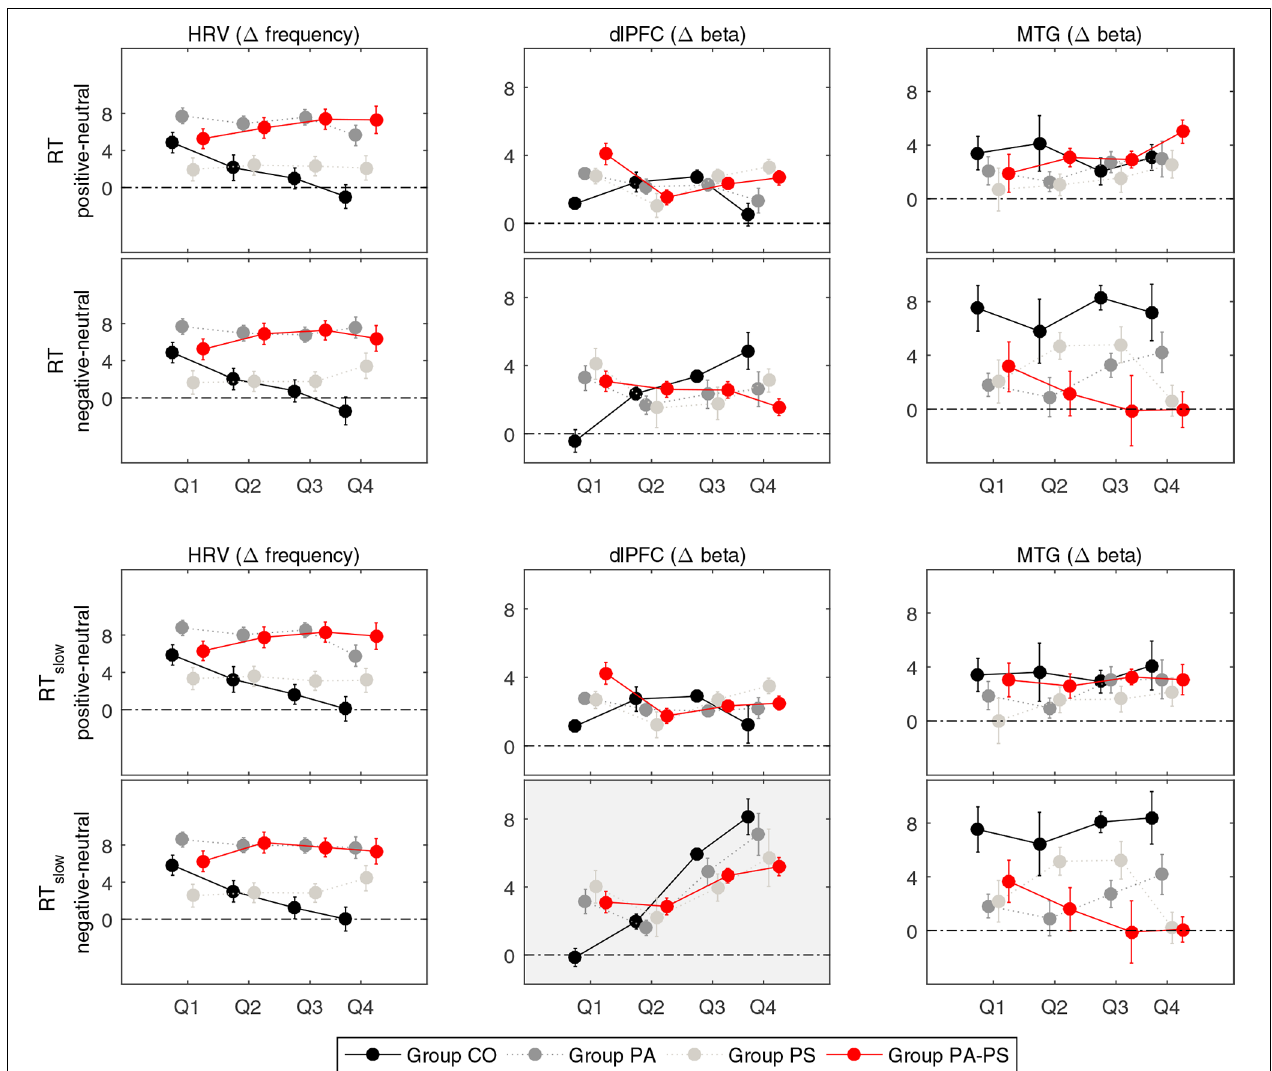
FIGURE 5 | Quantile analysis. Illustration of the quantile differences in heart rate variability (HRV), and the (cid:49) [tHb] beta estimates (DLPFC, MTG) per group (CO, PA, PS, PA-PS). Positive values indicate larger responses in the positive or negative compared to the neutral condition (i.e., positive minus neutral, and negative minus neutral). Error bars indicate standard error of the mean. HRV : Main effect of ‘group’ ( F = 19.116, p < 0.001). An effect of ‘quantile’ was observed in group CO between the first and fourth quantile (Q1 vs. Q4) for RT and RT slow . DLPFC : Main effects of ‘quantile’ ( F = 25.266, p < 0.001) and ‘interference’ ( F = 25.703, p < 0.001) for RT slow . An effect of ‘group’ was observed in the fourth quantile (Q4) for RT and RT slow . MTG: Main effect of ‘group’ ( F = 8.755, p < 0.001) and interaction effect of ‘interference’ × ‘group’ ( F = 4.481, p <